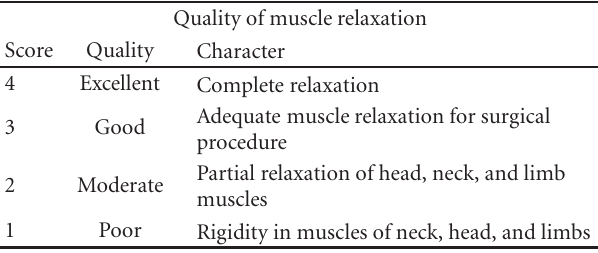
Table 1: Score card for quality of muscle relaxation.